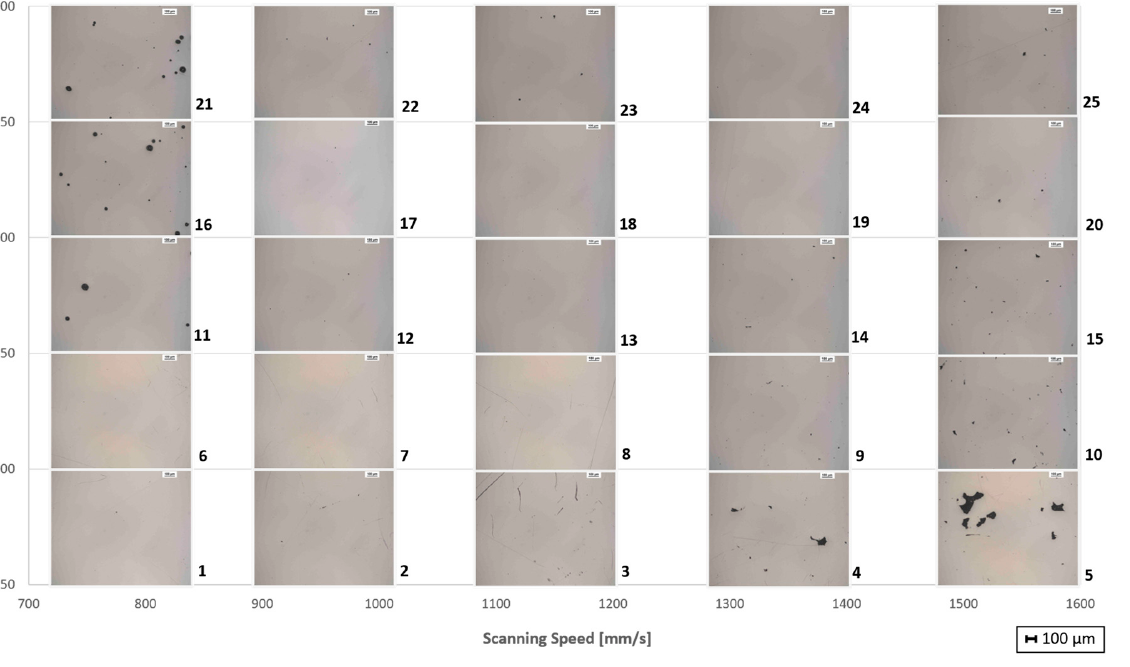
Figure 14. Porosity map (hatch distance value 0.11 mm, number in black indicate the sample). Table 5. Porosity tracking table.